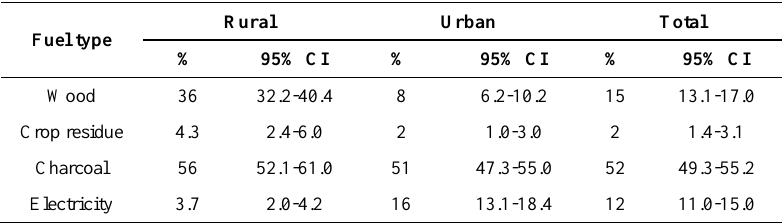
Table 1. Cooking fuel types of rural, urban and whole population